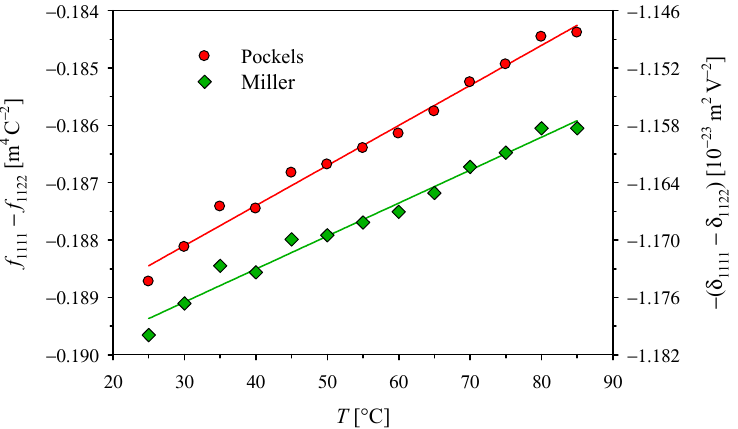
Figure 3. Temperature dependence of the intrinsic quadratic electro-optic coefficients with the linear interpolations f 1111 − f 1122 = f 0 (1 + a f T ) and δ 1111 − δ 1122 = δ 0 (1 + a δ T ), where the values at T = 0 °C are f 0 = − 0.19019(15) m 4 C − 2 and δ 0 = 1.1868(10) × 10 − 23 m 2 V − 2 , and the temperature coefficients are a f = − 3.67(13) × 10 − 4 K − 1 and a δ = − 2.91(13) × 10 − 4 K − 1 . − n o3 g Configuration (23) was used to perform measurements of the n e3 g effec- 3333 1133 tive coe ffi cient. The averaged results obtained for the two polarizer azimuths − 45° and +45° are shown in Figure 4. To our knowledge, the temperature dependence of the effec- tive coefficient 𝑛 (cid:2915)(cid:2871) 𝑔 (cid:2871)(cid:2871)(cid:2871)(cid:2871) − 𝑛 (cid:2925)(cid:2871) 𝑔 (cid:2869)(cid:2869)(cid:2871)(cid:2871) in KDP crystal has not been reported previously. We − n o3 g can only compare our result n e3 g = (+1.60 ± 0.04) × 10 − 20 m 2 V − 2 at 25 °C with 3333 1133 − n o3 g (cid:3627) = 3.1 × 10 − 17 m 2 V − 2 obtained using the static polarimetric tech- the value (cid:3627) n e3 g 3333 1133